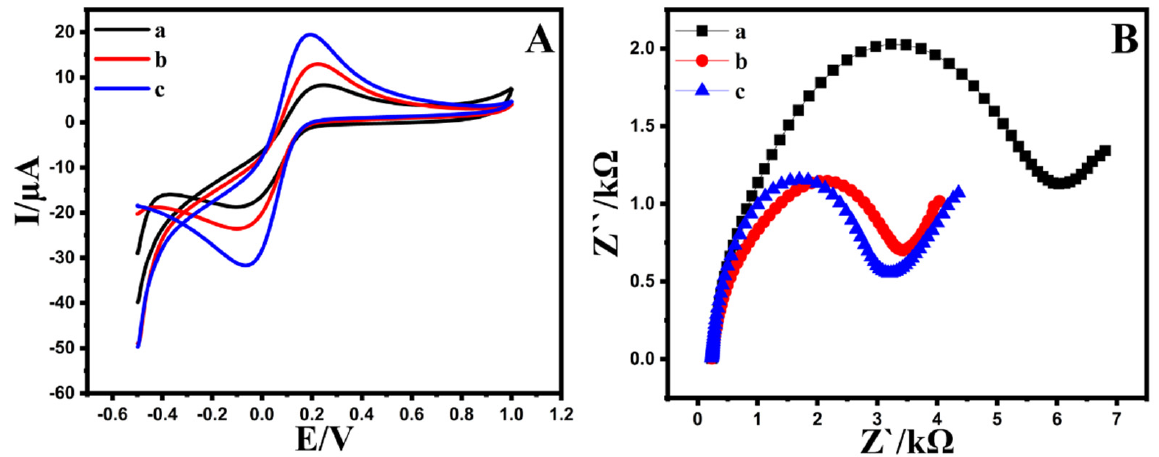
Figure 3. ( A ); CVs and ( B ); EIS at ( a ) bare SPE, ( b ) NiFe 2 O 4 /SPE, ( c ) Au@NiFe 2 O 4 /SPE in the presence of 5.0 mM [Fe(CN) 6 ] 3 − /4 − as redox probe containing 0.1 M